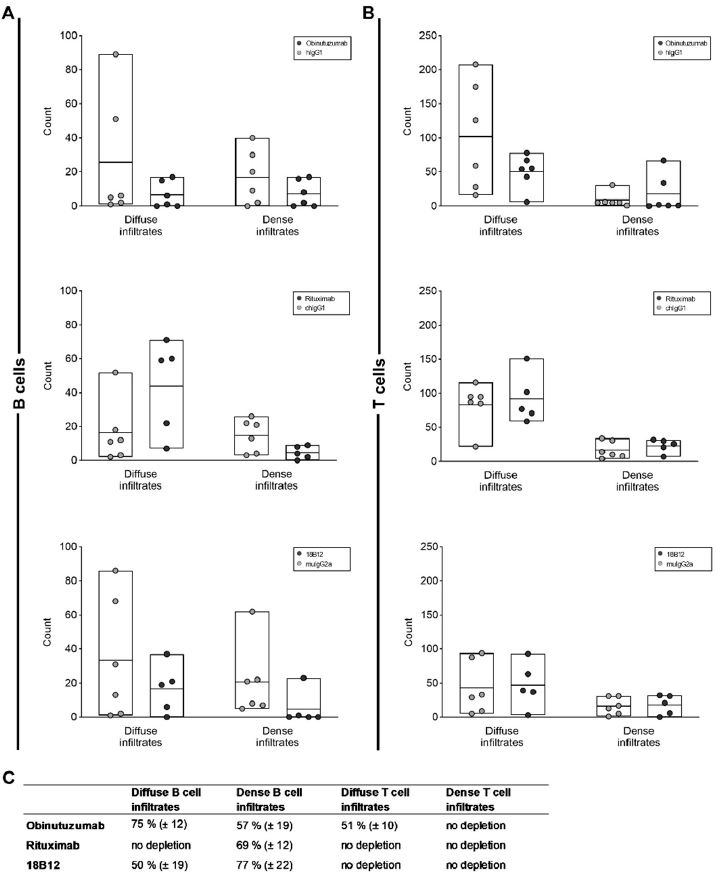
Figure 5. Effect of anti-CD20 mAbs on CNS-infiltrating B and T cells. The cerebella of 5–6 mice per group were analyzed 7 days after the end of treatment with anti-CD20 mAbs or isotype controls, as indicated in the figure insets. Thirty images per mouse were analyzed. Each circle represents the mean value for an individual mouse. The bars indicate the group mean value as well as minimum and maximum values. The following statistical tests were used for group comparisons: diffuse infiltrates in panel ( A ), Mann – Whitney U test (OBZ, RTX) and unpaired t test (18B12); dense infiltrates in panel ( A ), unpaired t test (OBZ, RTX) and Mann – Whitney U test (18B12); diffuse infiltrates in panel ( B ), unpaired t test; dense infiltrates in panel ( B ), Mann – Whitney U test (OBZ) and unpaired t test (RTX, 18B12). There was no statistically significant difference between any of the groups. ( C ) Relative depletion (mean ± SEM) of B cell and T cell infiltrates in anti-CD20 mAb- compared to isotype control-treated groups.